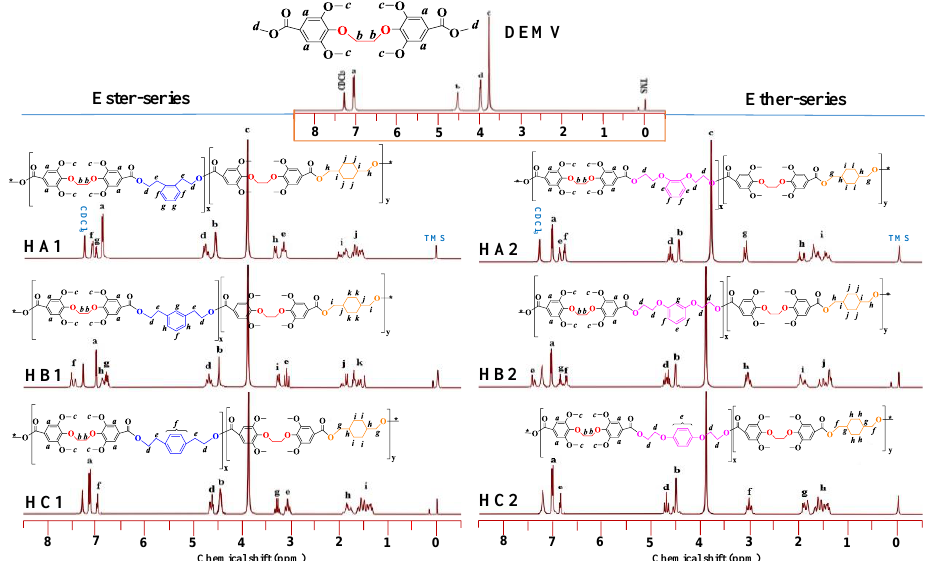
Figure 6. Chemical structure and ¹H NMR spectra of poly(ether-ester)s.